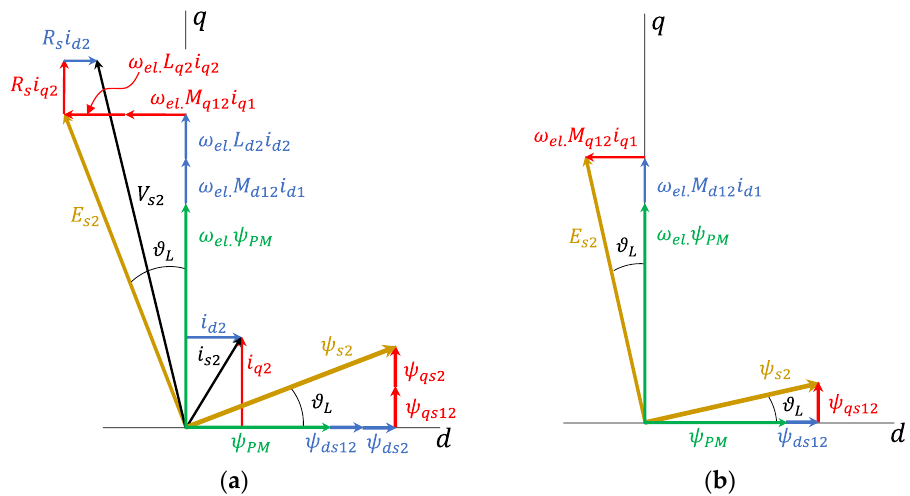
Figure 18. Vector diagram of the second three-phase system D – E – F in the synchronous reference